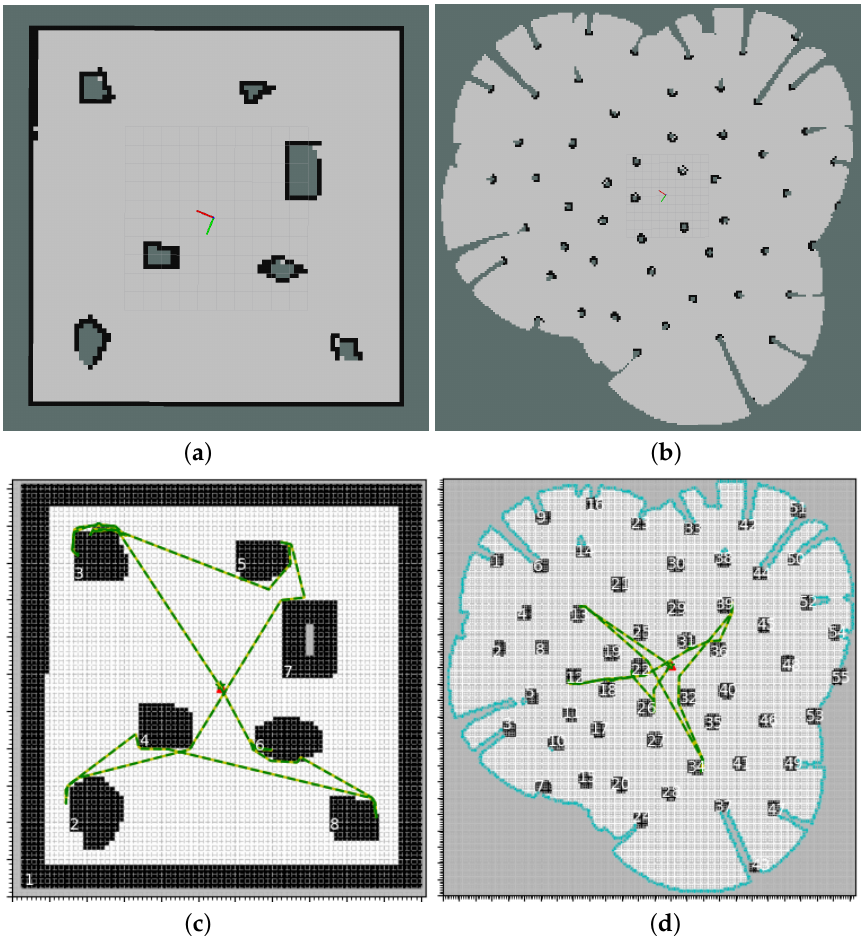
Figure 7. Results from Gazebo simulations. Maps generated my gmapping for room and forest environments are shown in ( a , b ) respectively, and internal algorithm maps for them with expanded obstacles and total paths taken being shown in ( c , d )